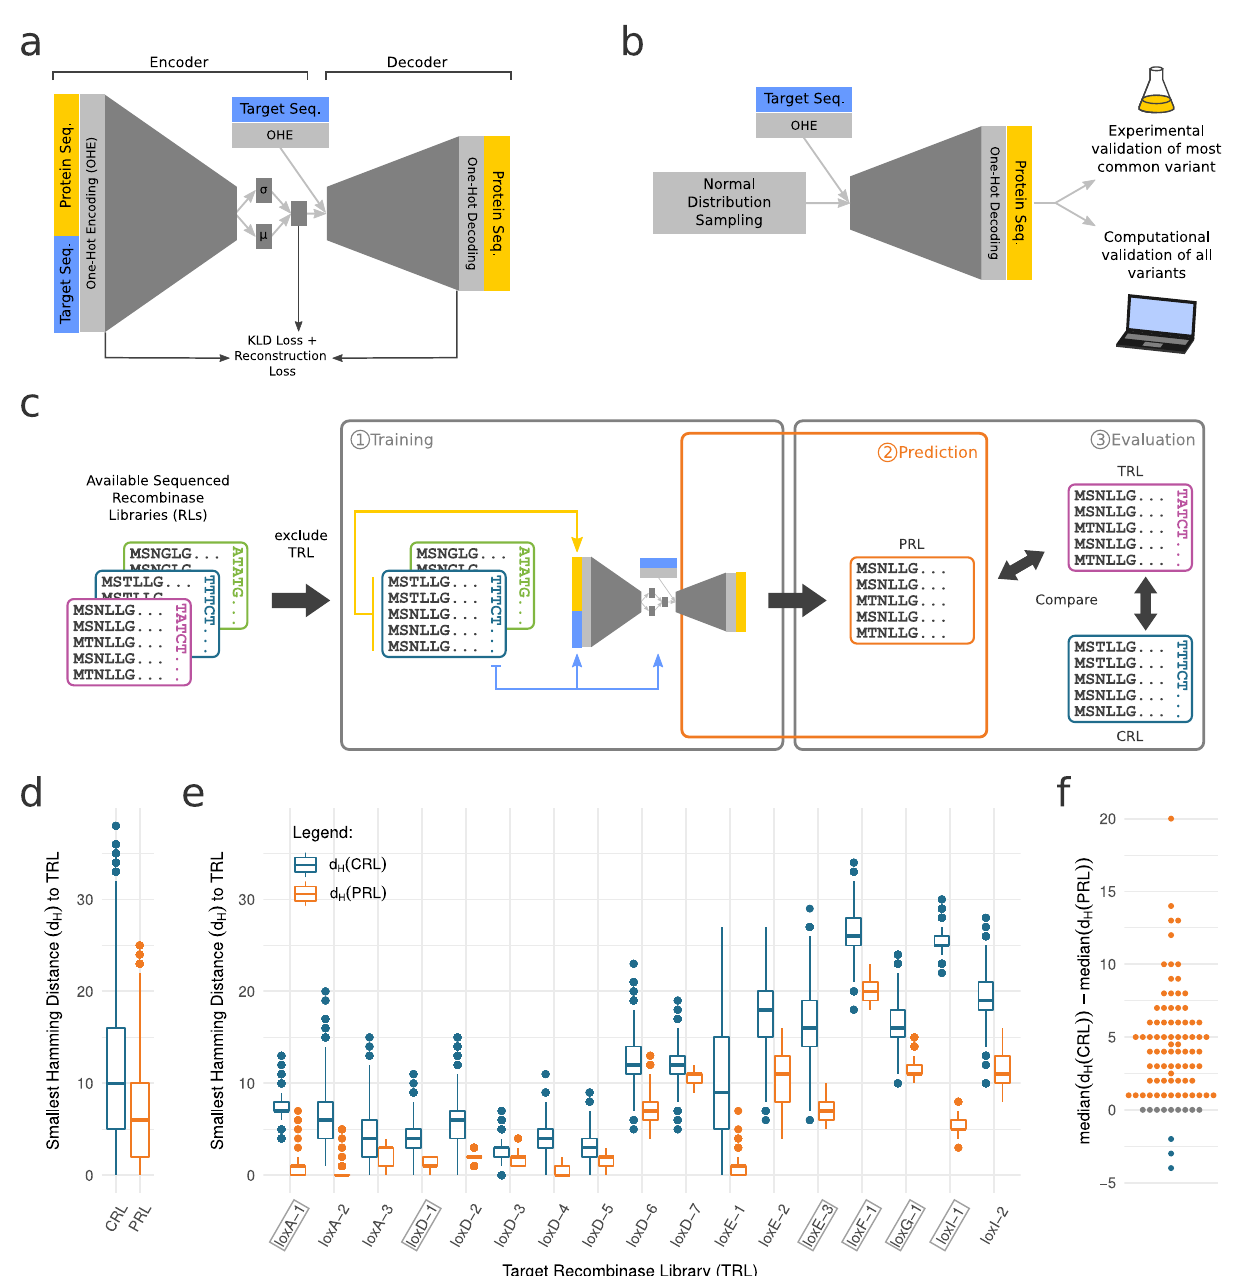
Fig. 2 | Training and computational validation of RecGen. a A Conditional Var- iational Autoencoder (CVAE) is trained with one-hot encoded half-site target sequences and recombinase proteinsequences asinput. The encoder capturesthe sequence diversity in a latent space, from which, in combination with the target sequence,thedecoderreconstructstheproteinsequence.Thefullmodelistrained using a reconstruction loss in combination with the Kullback – Leibler divergence (KLD) that ensures the before mentioned diversity of predicted sequences. b Trained CVAE decoder generates recombinase protein sequences with the input of a recombinase target sequence and normally distributed random numbers, which diversi fi es the outcome. The resulting protein sequences for known target sites are computationally validated (explained in part c) and the most commonly predicted sequencesfor de fi nedtargetsare validated experimentally. c Leave-one- out cross-validation (LOOCV) of CVAE model. (1) CVAE is trained with all available sequenced recombinase libraries excluding the target recombinase library (TRL).